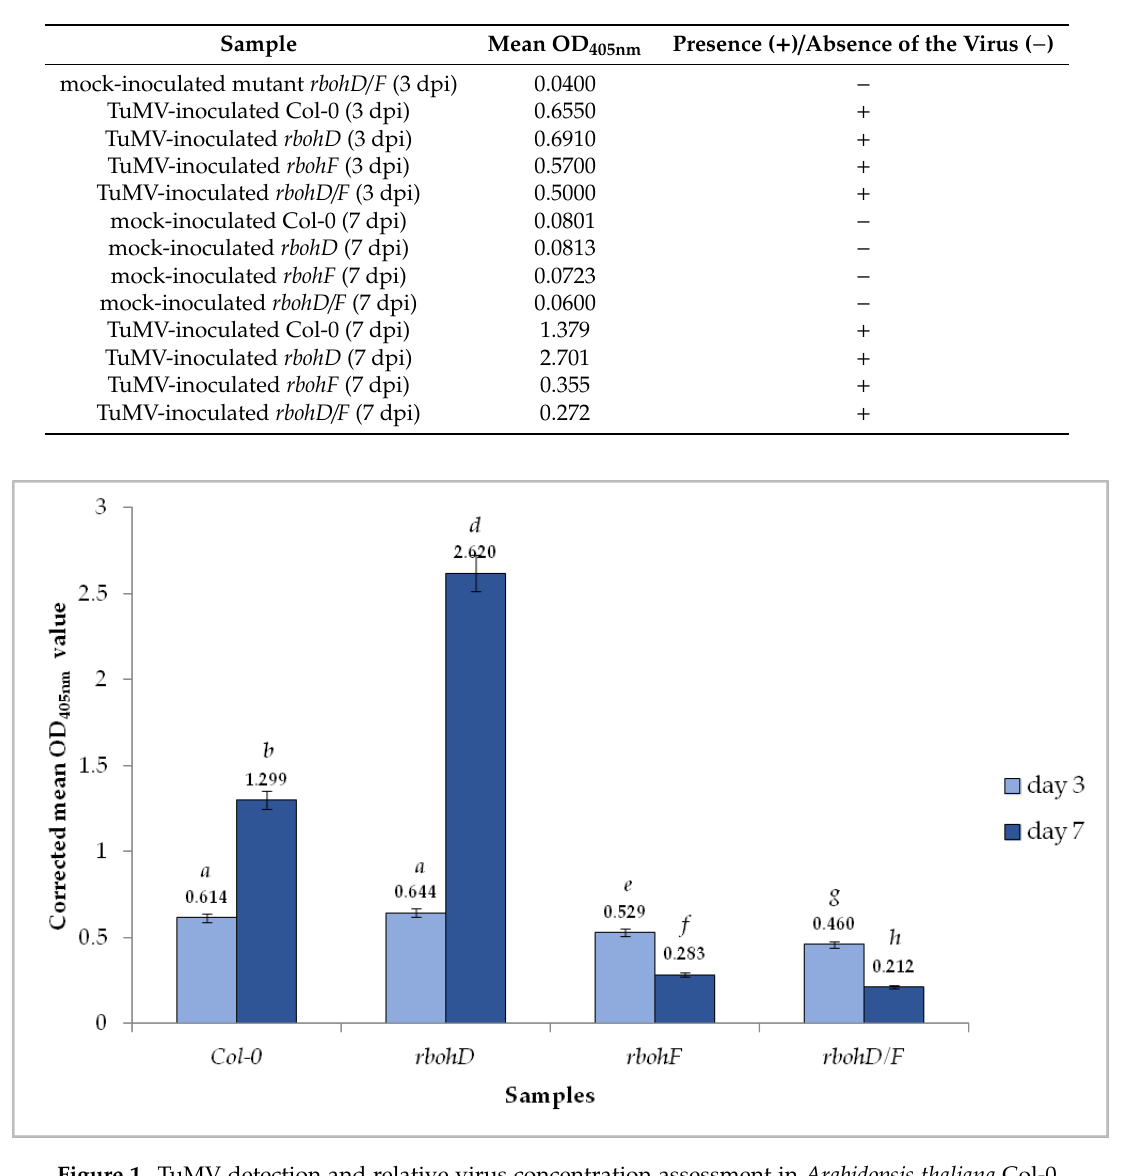
Figure 1. TuMV detection and relative virus concentration assessment in Arabidopsis thaliana Col-0 and rbohD , rbohF and rbohD/F mutants at 3 and 7 days after inoculation. Values represented are mean of corrected OD 405nm values. Significant differences between classes at p < 0.05 level of significance were assessed by analysis of variance (ANOVA) with post-hoc Tukey HSD. The statistically significant values are marked by letters above chart bars.